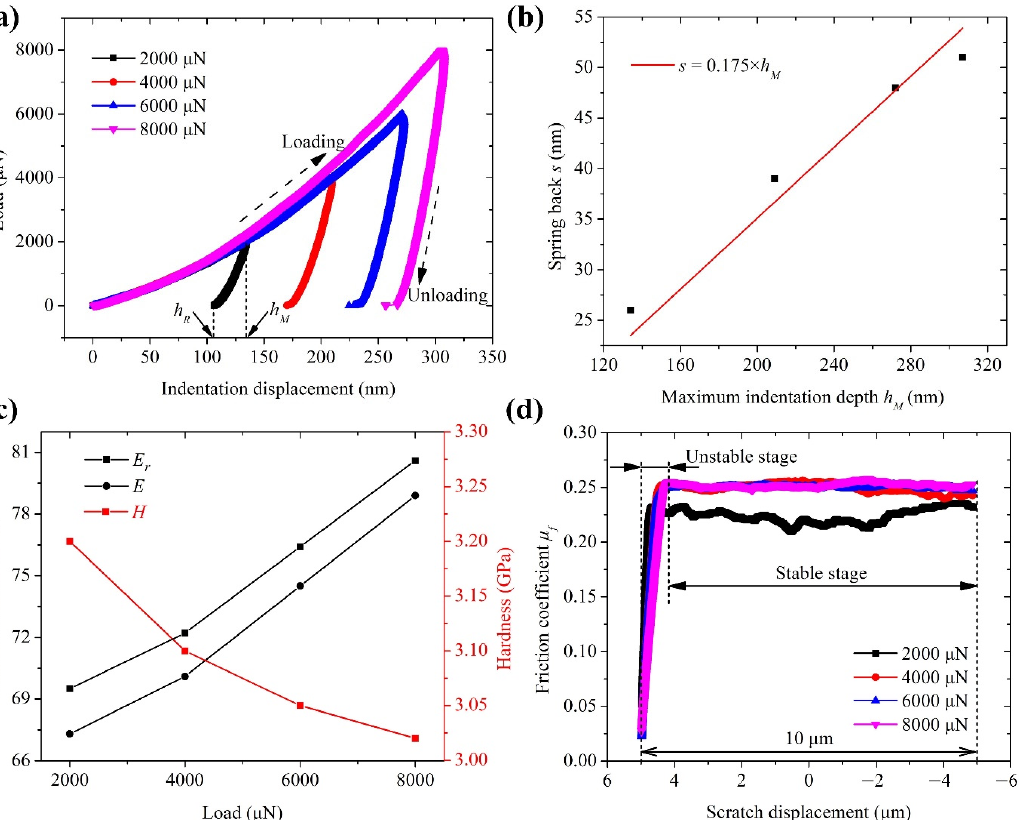
Figure 3. ( a ) Load-displacement curves under different indentation loads; ( b ) relationship between the spring back s and the maximum indentation depth h M ; ( c ) reduced elastic modulus E r , elastic modulus, and hardness H of ZnSe under different indentation loads; ( d ) friction coefficient ( μ f )- scratch displacement curves under different scratch